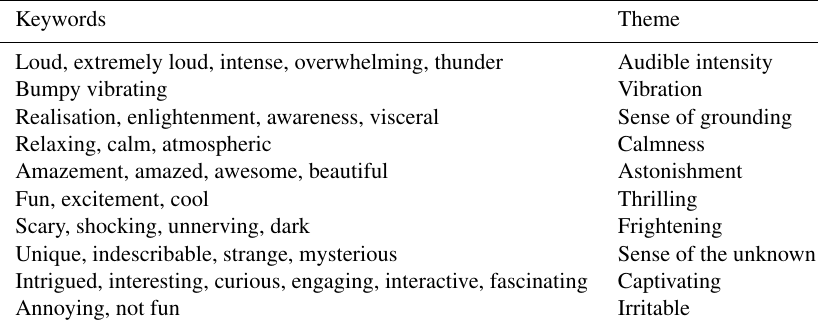
Table 3. Shows a thematic analysis of the feedback from written feedback from the hertz